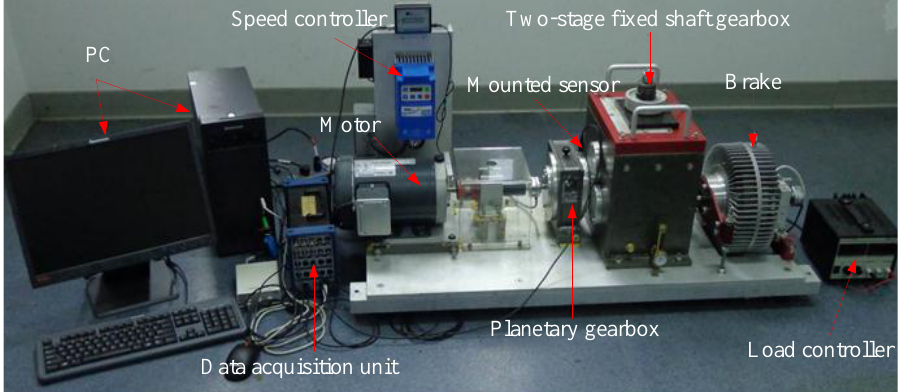
Figure 12. The experiment rig of planetary